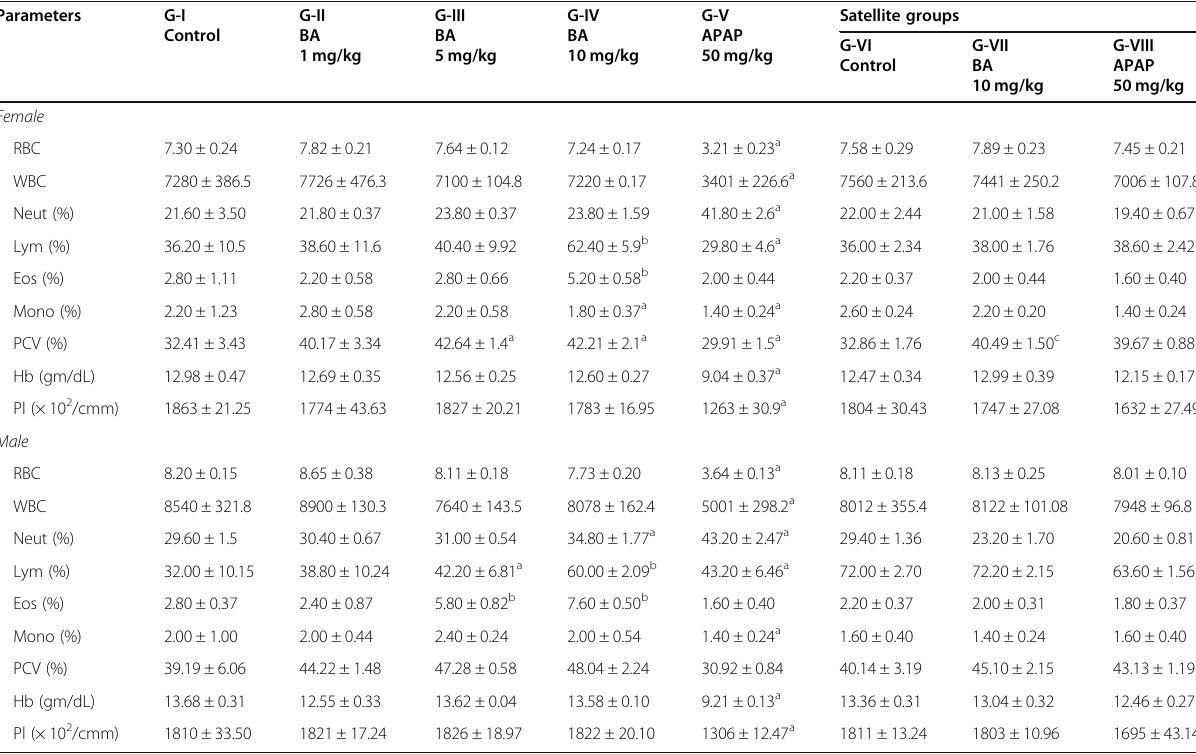
Table 7 Effects of sub-acute oral administration of BA and APAP on selected hematological parameters of Wistar rats ( n = 5/sex)